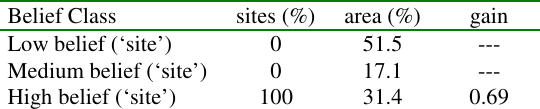
Table 2. Performance of the predictive model after